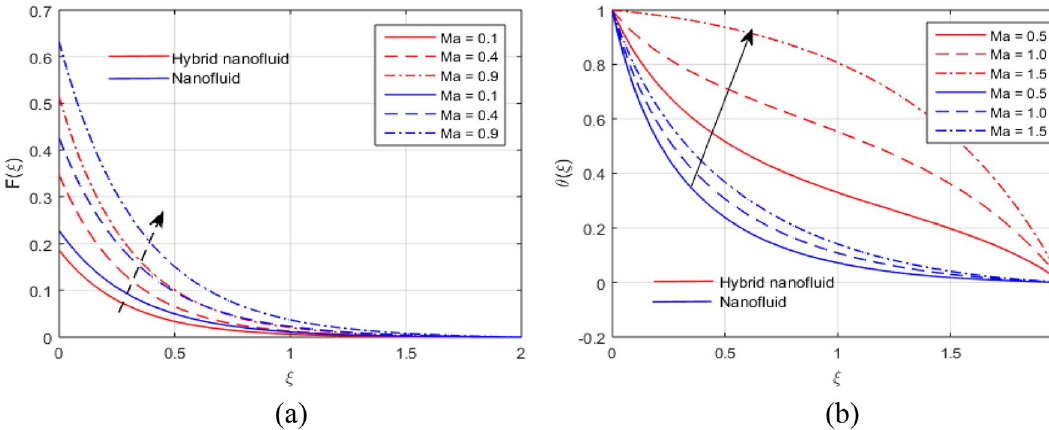
Figure 17. ( a , b ) Influence of Ma on F (ξ) and θ(ξ) .